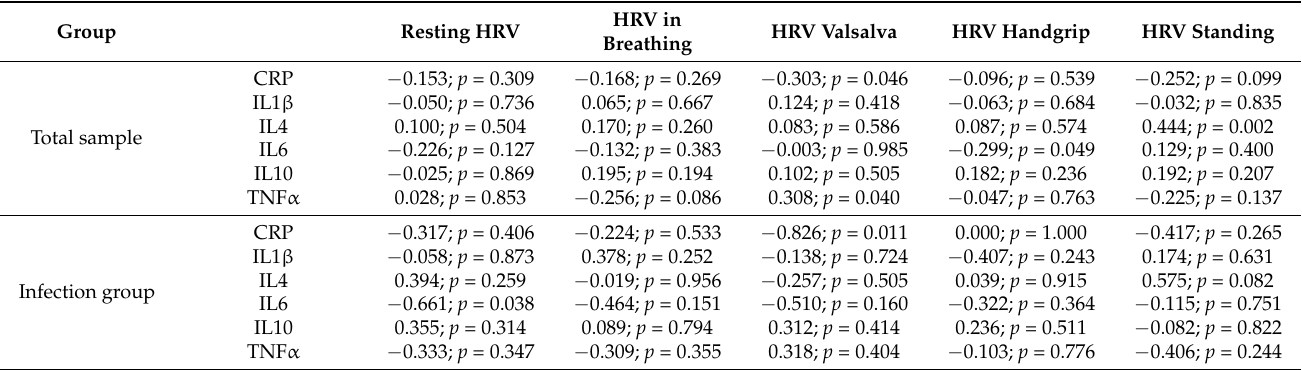
Table 2. Spearman’s correlation coefficients and p ‐ values for the week 1 association between heart ‐ rate variability (HRV) and inflammatory markers. 1